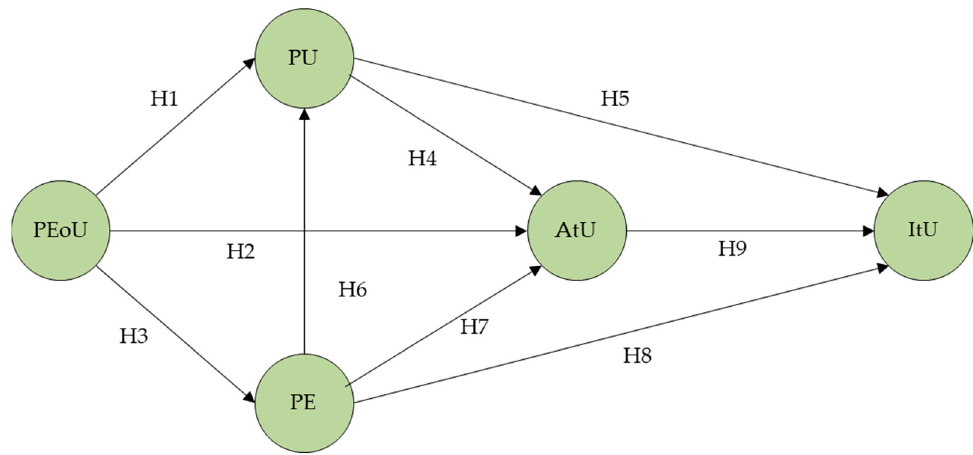
Figure 6. The research model. PEoU: perceived ease of use; PU: perceived usefulness; AtU: attitude toward using; ItU: intention to use; PE: perceived enjoyment.